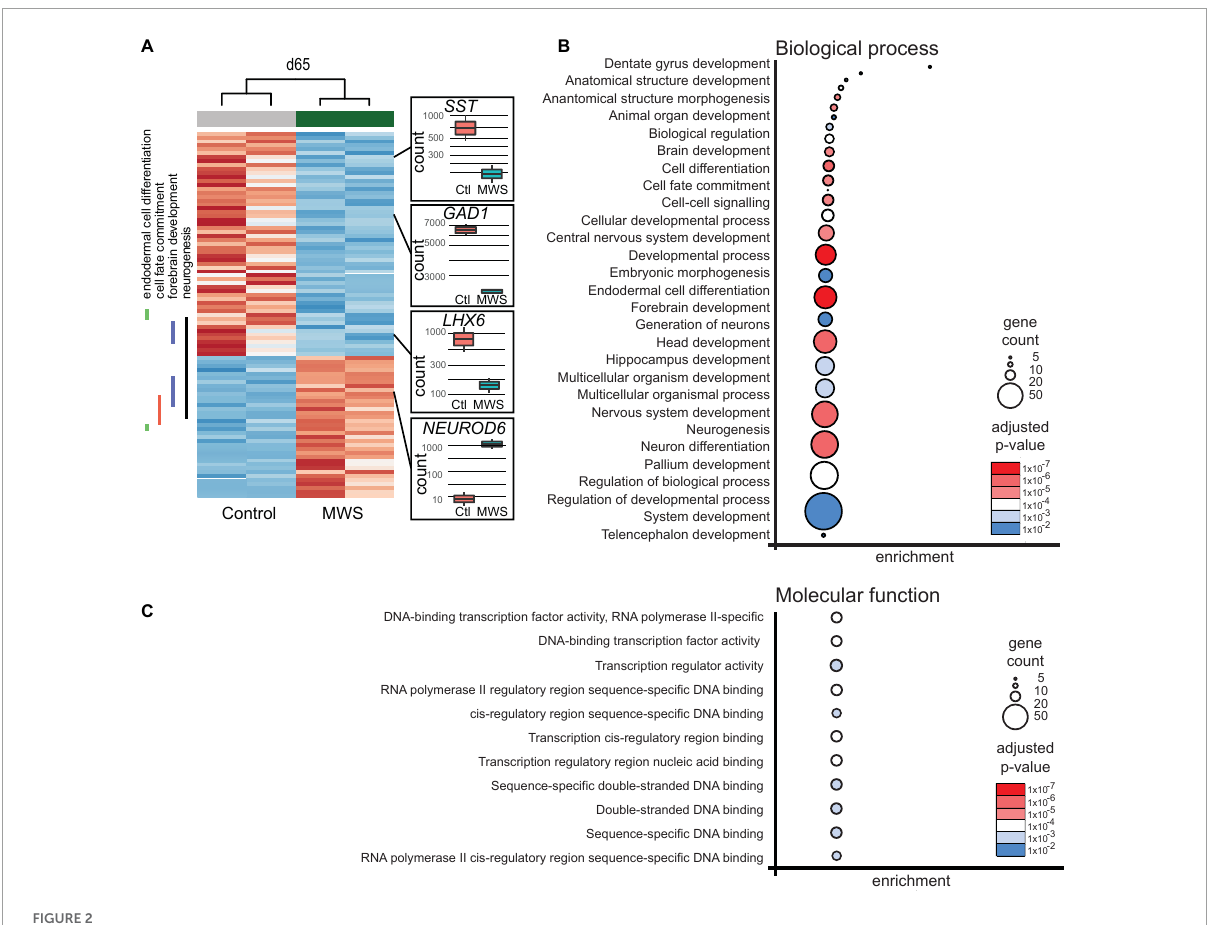
FIGURE2 (A) Hierarchial clustering (z-scores) of 93 differentially expressed genes in two Ctl-iPSC GABA and two MW-iPSC GABA lines at d65 of differentiation from RNAseq. The expression (normalized counts) of selected genes ( SST , GAD1 , LHX6 , NEUROD6 ) of importance for interneuronal development is highlighted as bar and whisker plots in Ctl-iPSC GABA ( n = 2) and MW-iPSC GABA ( n = 2). (B,C) GO enrichment analysis of 93 DEGs at d65 in MW-iPSC GABA cells showing the top 28 list of biological processes (B) and top 11 molecular functions (C) . Categories are listed according to adjusted p-values and number of DEGs in each category (gene count; Supplementary Tables 2A,C ).